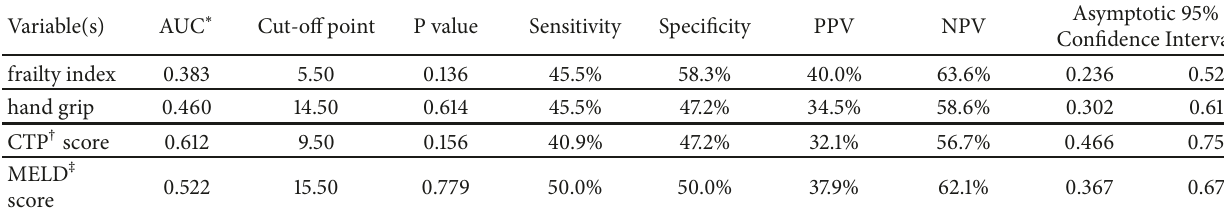
Table 3: Results of ROC curve analyses of predictors of hospital readmission.